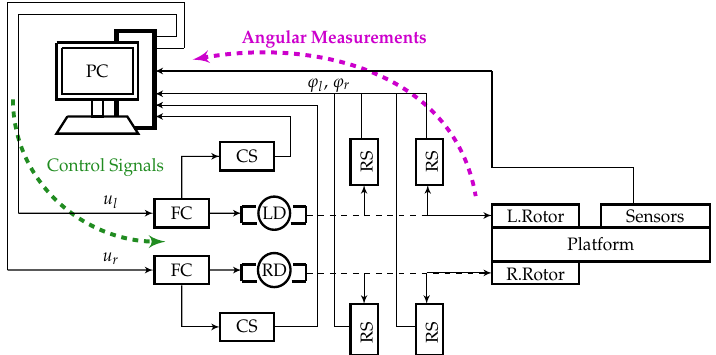
Figure 2. Functional electrical diagram for setup